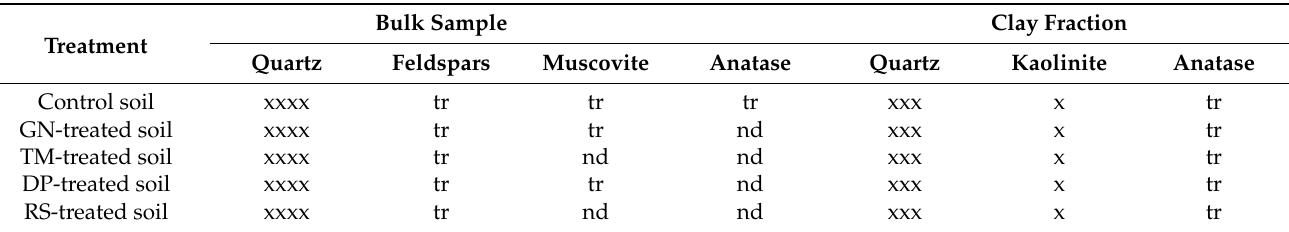
Table 3. Mineralogical compositions in bulk soil samples and clay fractions of topsoil (0–15 cm) of sandy soils in year 22 of the incorporation of organic residues of different biochemical quality 1 .